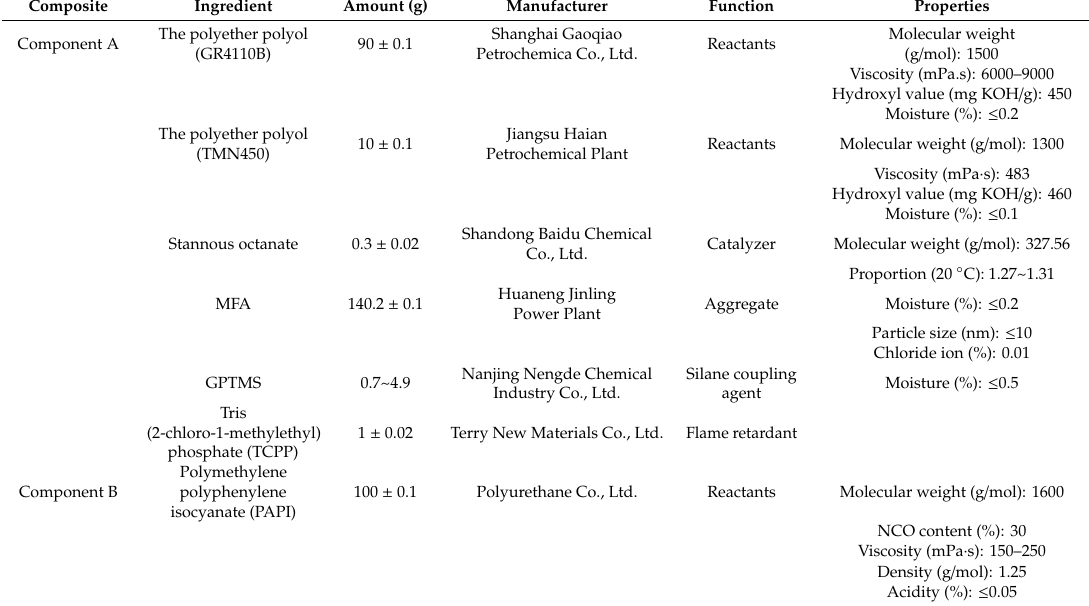
Table 1. Components of polyurethane / mesoscopic fly ash (PU / MFA) composites.